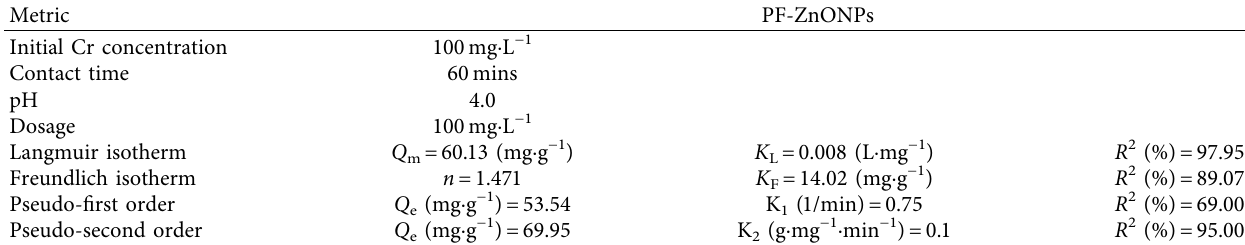
Figure 9: Pseudo-first-order and pseudo-second-order equations of Cr (VI) on zinc oxide nanoparticles (ZnONPs) and plant-fabricated zinc oxide nanoparticles (PF-ZnONPs). Table 1: Experimentally determined kinetic, Langmuir, and Freundlich parameters for Cr (VI) adsorption by plant-fabricated zinc oxide nanoparticles (PF-ZnONPs).